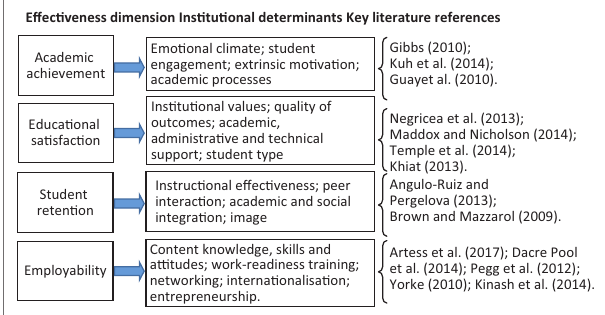
FIGURE 1: Institutional determinants of four constructs of institutional